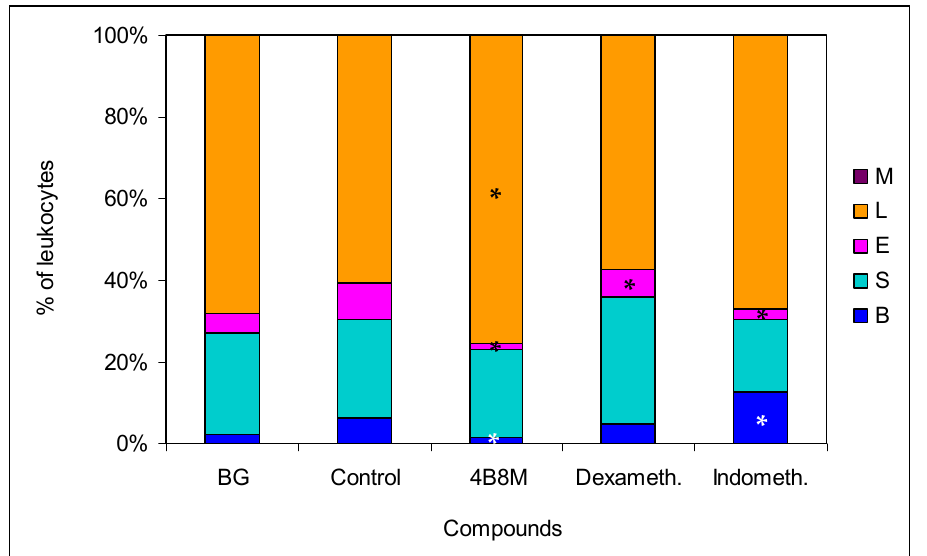
Figure 9. Effects of the compounds of blood cell type composition in mice with pleurisy: the mice were sensitized intraperitoneally (i.p.) with 50 µ g of ovalbumin (OVA) in Maalox as an adjuvant. After 14 days, the mice were injected with 12.5 µ g of OVA into pleural cavity. Two hours before administration of the eliciting dose of the antigen, the mice were given per os 250 µ g of 4B8M. The reference compounds—dexamethasone (125 µ g / mouse) and indomethacin (250 µ g / mouse)—were also given per os. On the next day, mice were bled and the smears were analyzed; up to 100 cells were counted for each preparation. The results are presented as the percentages of main cell types: mature neutrophils (segments, S), neutrophil precursors (bands, B), eosinophils (E), lymphocytes (L), and monocytes (M). Mean values for each group are shown. * Control vs. compounds p < 0.05 (ANOVA).